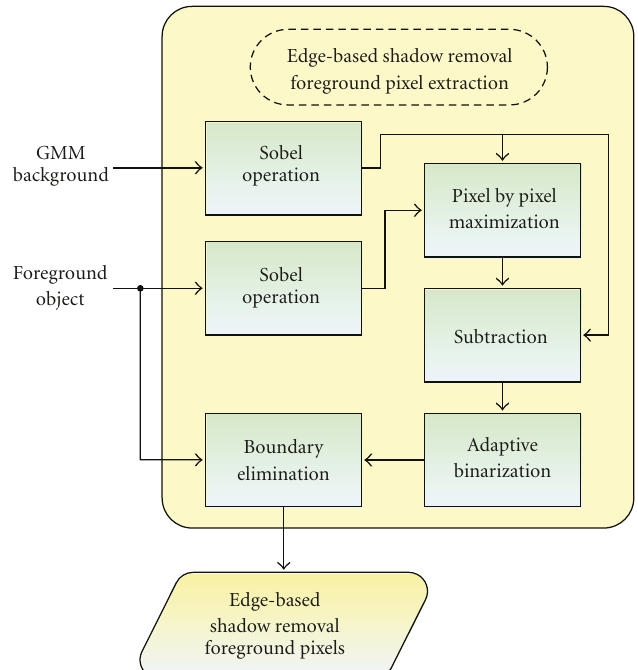
Figure 2: The flowchart of foreground-pixel extraction by edge-based shadow removal.